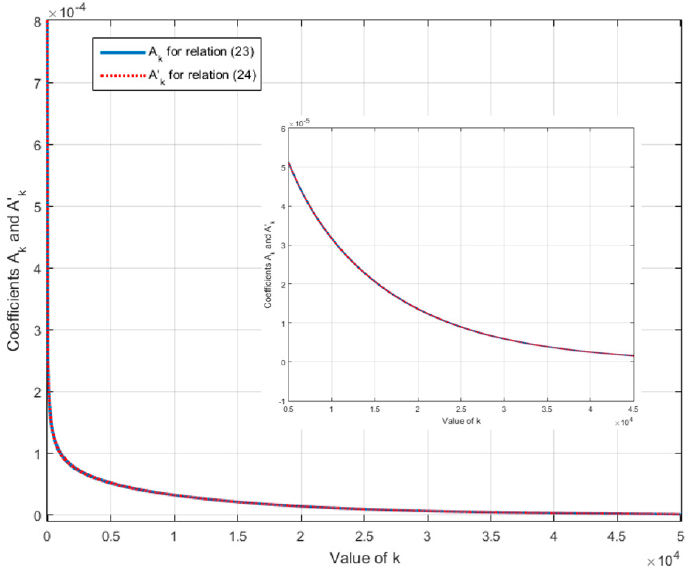
Figure 2. Comparison of coefficients A ′ k in relation (25) which tends towards coefficients A k in (24) and zoom inside the figure.